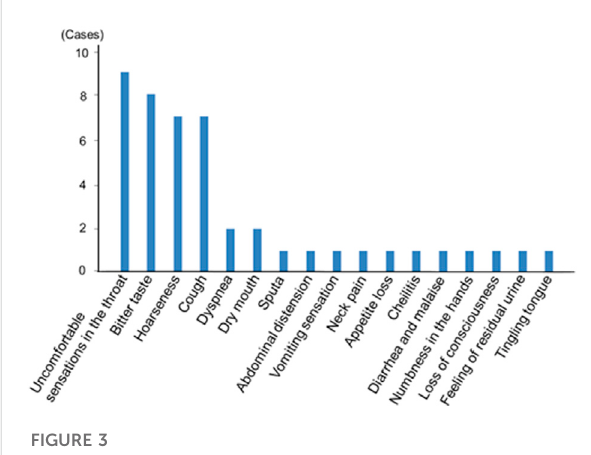
FIGURE 3 Newly seen adverse effects after the use of the single inhaler fl uticasone furoate/umeclidinium/vilanterol 200/62.5/25 μ g in asthma patients. Most adverse effects were related to local side